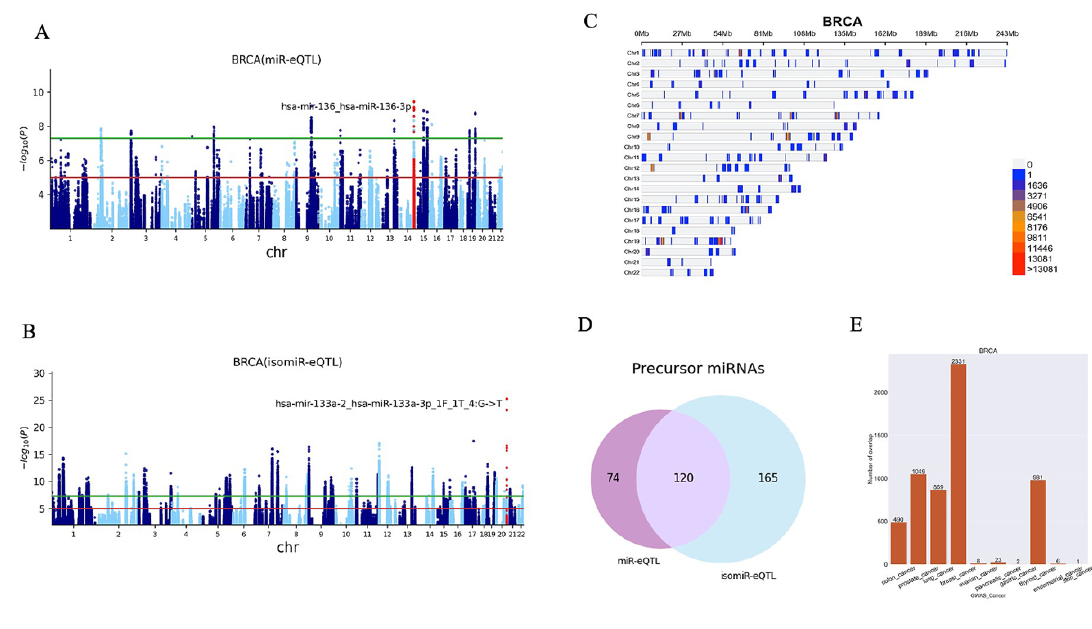
Figure 2. ( A ) The Manhattan plots of miR-eQTL. The most significant miRNA is labelled; it includes the name of the precursor and the miRNA. ( B ) The Manhattan plot of the isomiR-eQTL. The most significant isomiR is labelled; it includes the name of the precursor and the isomiR. ( C ) Density plot shows the position of all miR and isomiR-eQTL (FDR < 0.05) in the genome. ( D ) The Venn graph shows the numbers of miRNA precursors that were discovered in breast cancer samples. ( E ) Bar charts show the number of overlap.